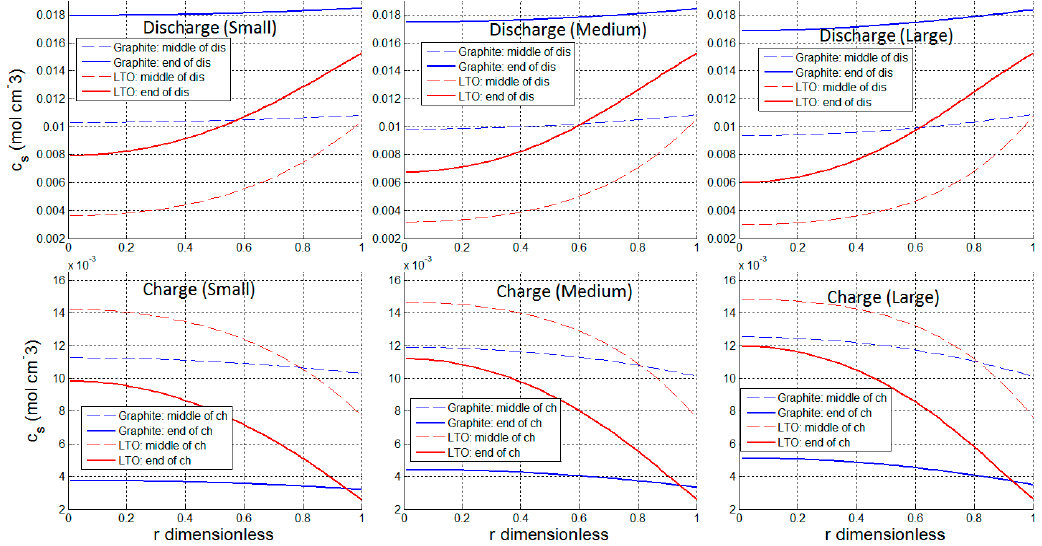
Figure 6. Ion concentrations in solid particles of graphite and LTO half-cells during 0.045 C, 0.089 C, and 0.13 C cycles.